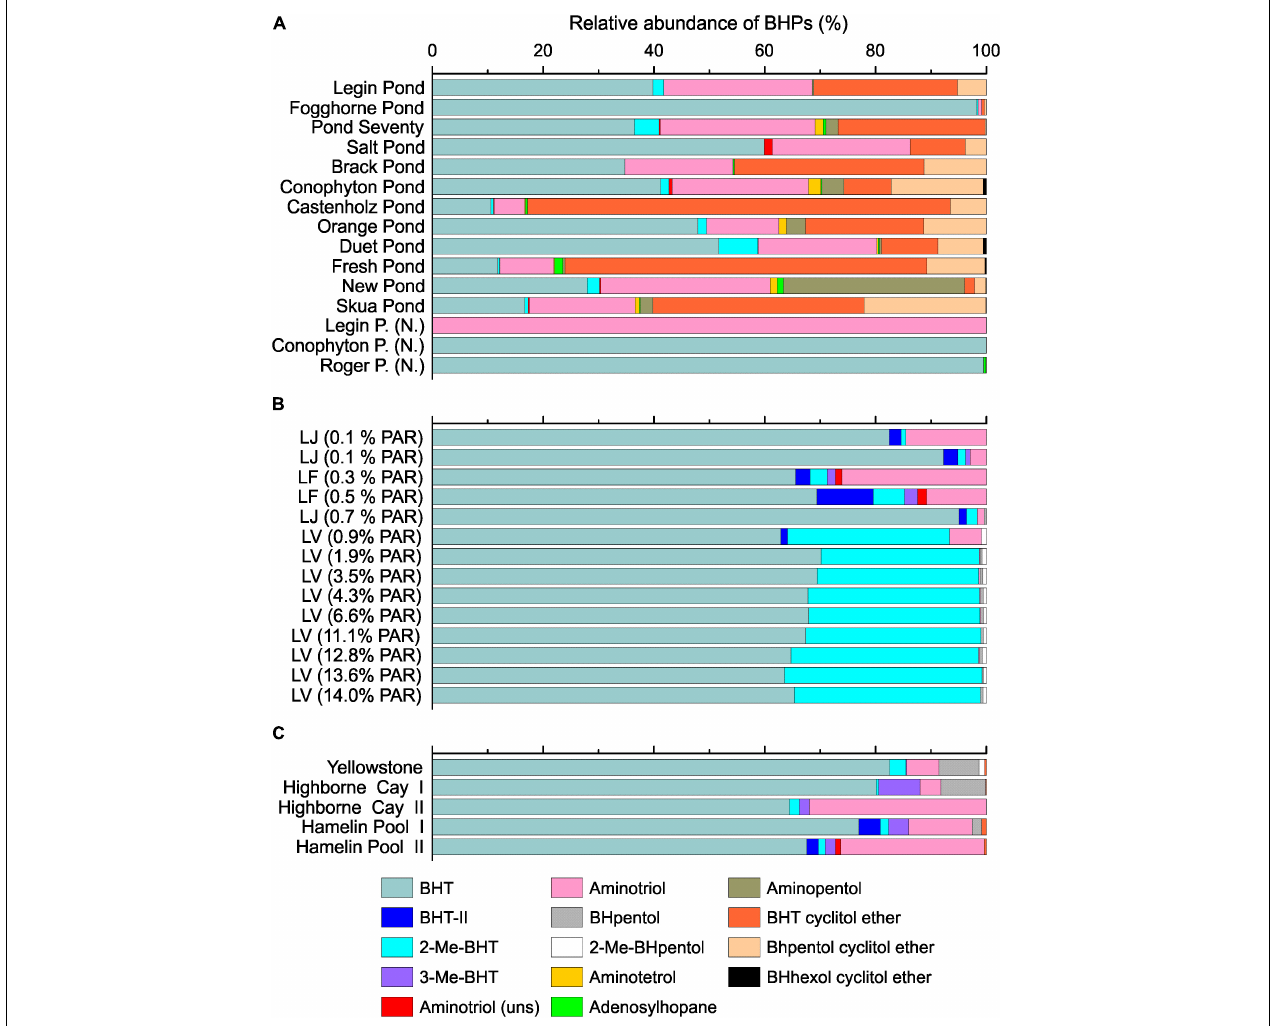
FIGURE 7 | Bacteriohopanepolyols composition in the microbial mats from the meltwater ponds (A) . Samples with (N.) indicate ‘Nostoc spheres’ that were collected in three different meltwater ponds. Panel (B) shows the relative BHP distribution from the three different Antarctic lakes: Lake Joyce (LJ), Lake Fryxell (LF) and Lake Vanda (LV). The brackets show the percentage of photosynthetically active radiation (PAR) that reached the microbial mats. The PAR was adopted from previous studies (Jungblut et al., 2016; Mackey et al., 2017b, 2018; Matys et al., 2019). Panel (C) shows the relative abundance of BHPs in the microbial mats from the Yellowstone National Park (United States), Highborne Cay (Bahamas), and Hamelin Pool